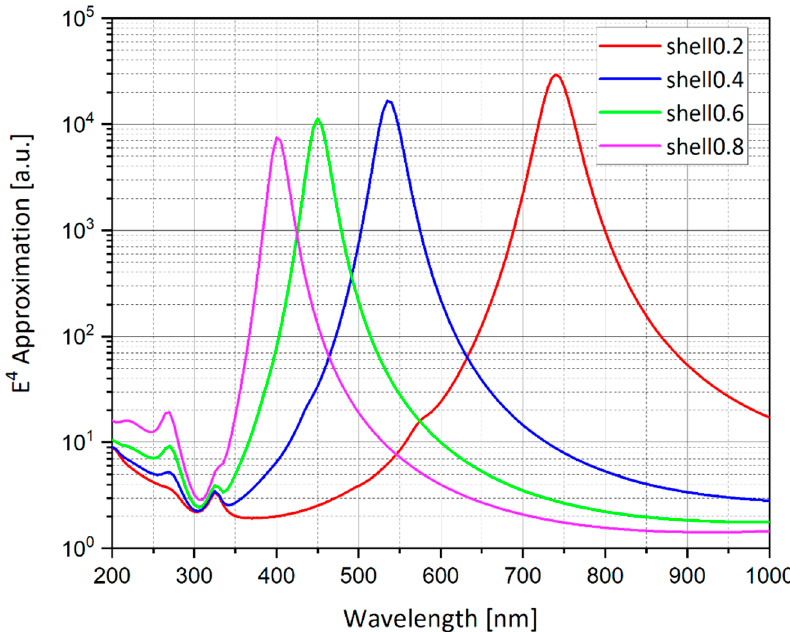
Figure 17. Enhancement curves for spherical nano-shells with outer radius (R) of 20 nm and inner radius (r) such that the nano-shell thickness is T = R-r. The nano-shells thickness ranges between T( ∆ = 0.2) = 1.433 nm and T( ∆ = 0.8) = 8.303 nm. The shells are excited by a plane wave. The reso-